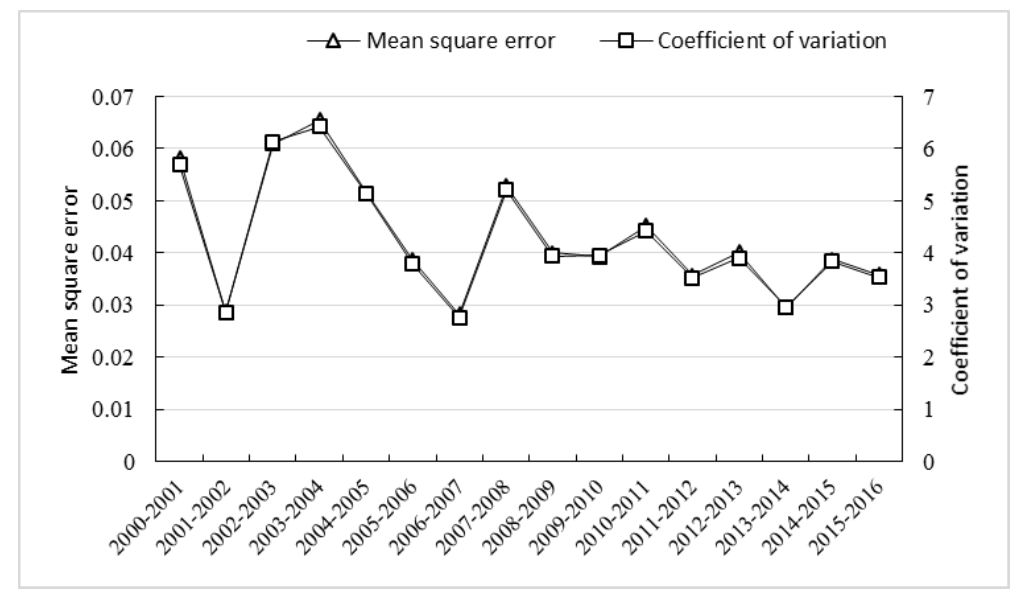
Figure 9. Changes in average variance and the coefficient of variation of PTC.